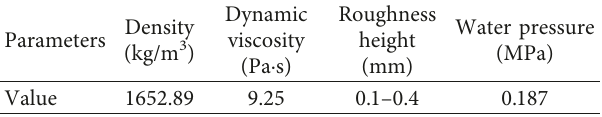
Figure 10: Computational model diagram. Table 4: Parameters of semiempirical calculation.